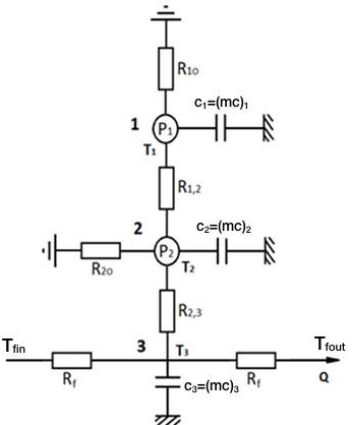
Figure A1. Electrical circuit diagram of an analog model of a flat-plate solar collector. Reproduced